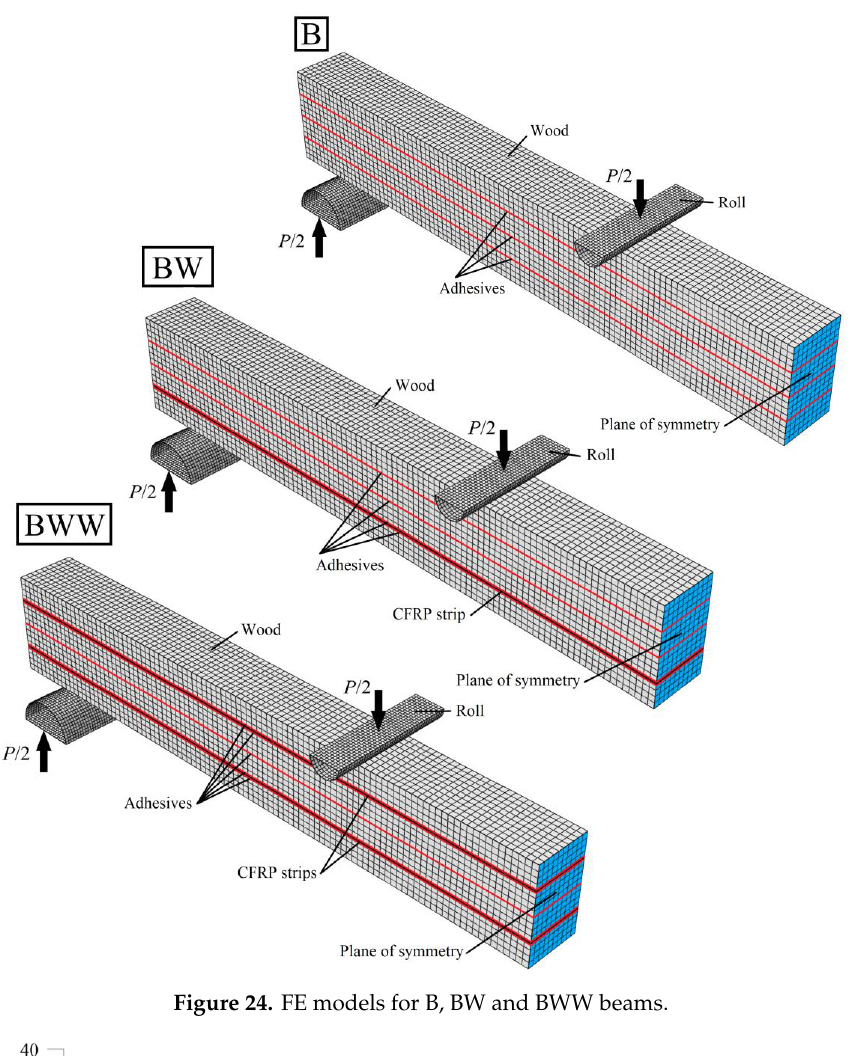
Table 4. Average properties of CFRP tapes according to References [67,68].